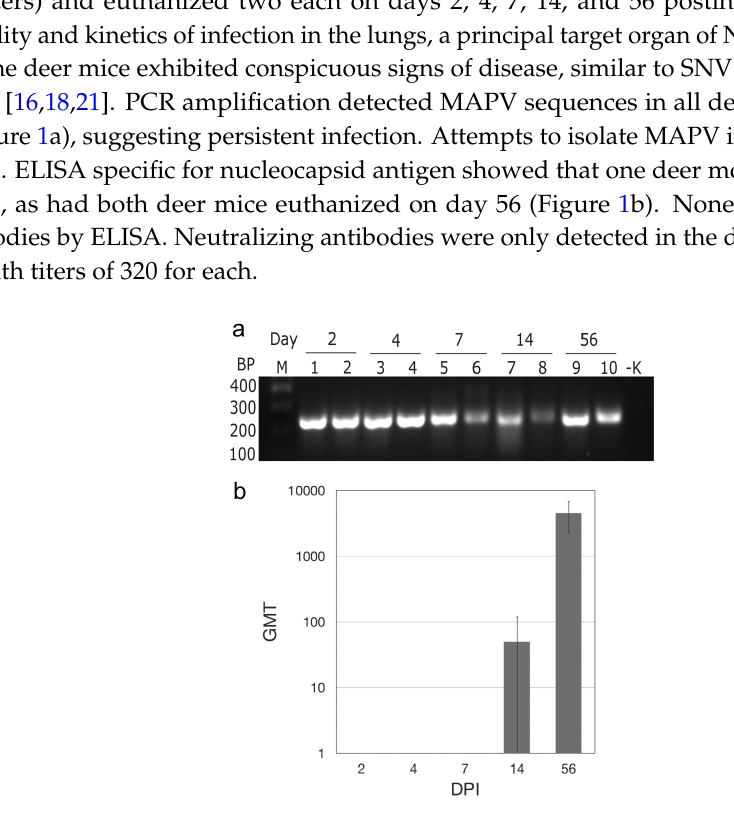
Figure 1. Maporal virus (MAPV) infects deer mice. After subcutaneous inoculation in the hindquarter, MAPV RNA was detected in the lungs two days later and persisted though at least 56 days; M marker, BP base pairs, ‐ K negative control ( a ). Antibodies to MAPV nucleocapsid appeared as early as 14 days PI and increased in titer by day 56 ( b ).